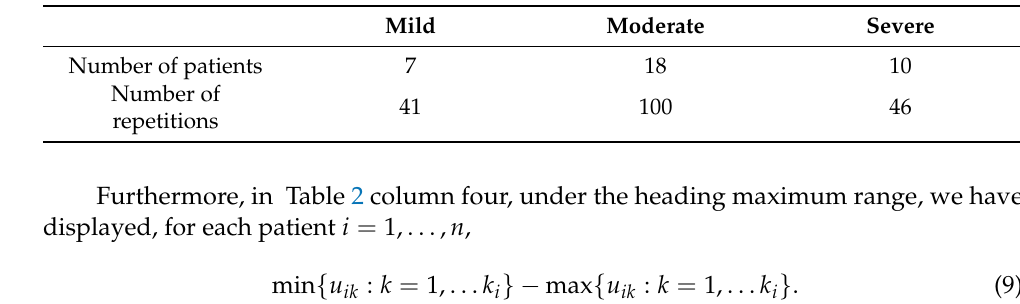
Table 3. Summary of Table 2 encapsulating the number of patients and total number of repetitions per stage of the disease: mild, moderate and